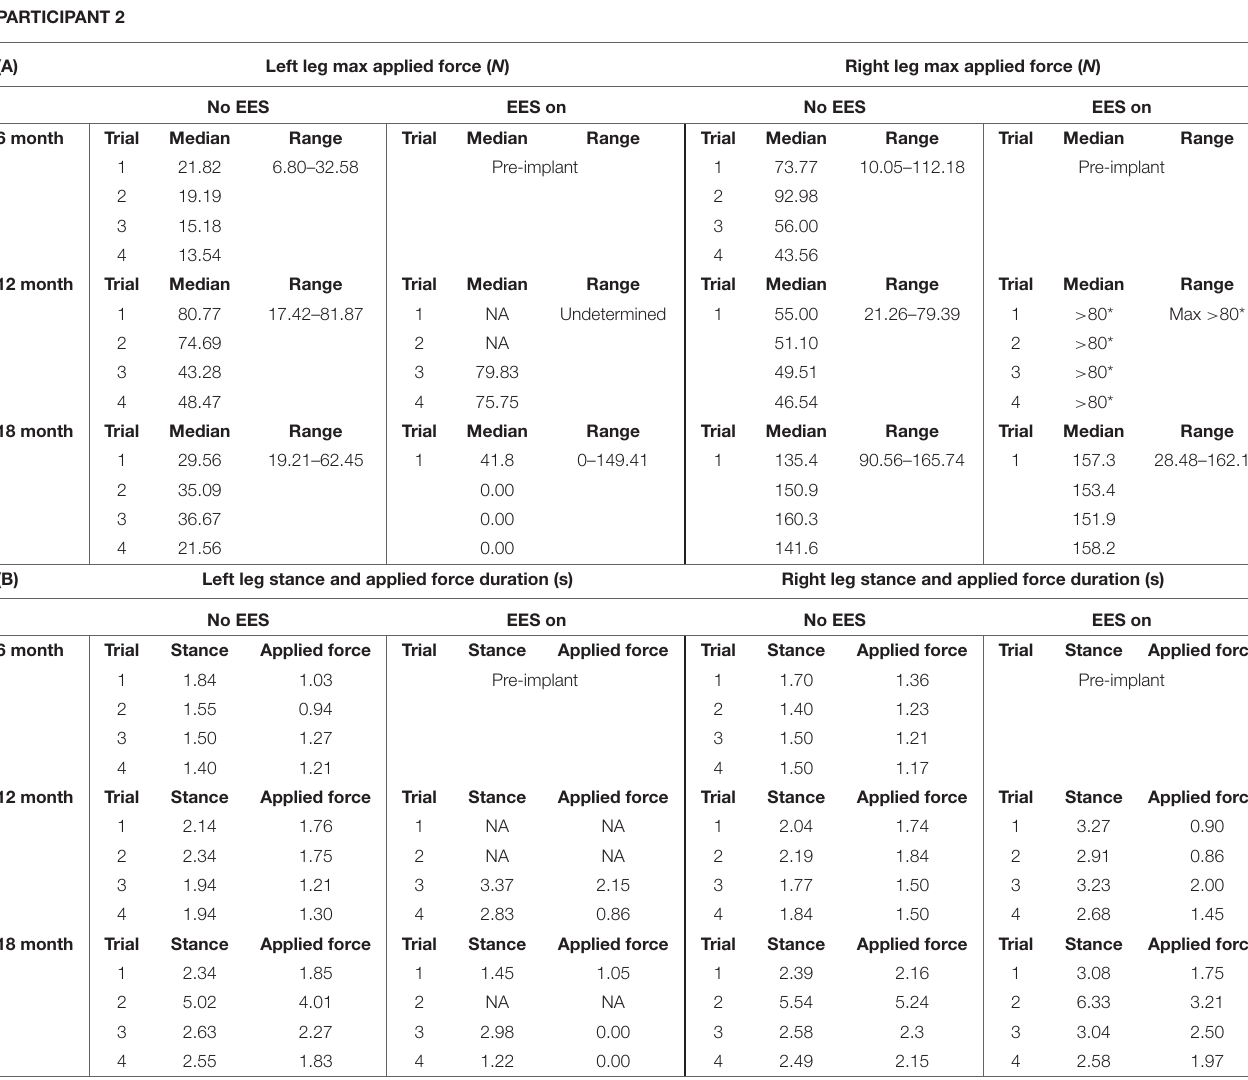
TABLE 2 | Participant 2: (A) maximum applied force values for left and right leg including all trials at month 6, 12, and 18 and (B) stance and applied force duration values for left and right legs including all trials at month 6, 12, and 18. PARTICIPANT